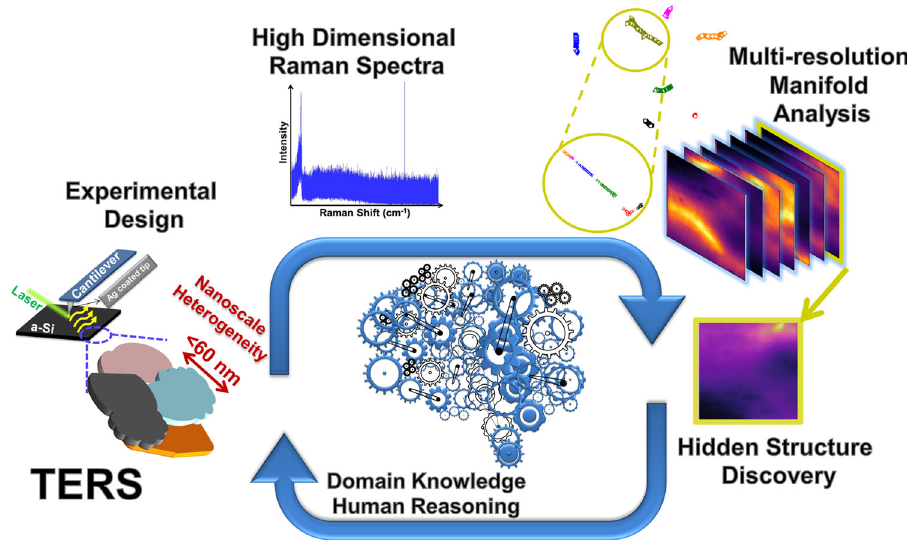
Fig. 1 The integrated work fl ow comprising hyperspectral TERS imaging and the multi-resolution manifold learning (MML) algorithm. The low dimensional physical parameters characterizing material structures such as local defects and atomic vibrations are translated into the high dimensional Raman spectra via hyperspectral tip-enhanced Raman spectroscopy (TERS) imaging transfer functions. The intrinsic low dimensionality of the physics suggests the structure of TERS measurements on the sample as a whole can be projected to a low dimensional latent manifold space via the multiresolution manifold learning (MML). Exploration data analysis such as clustering can be ef fi ciently conducted on the low-dimensional manifold space to reveal salient features for evaluating material structure heterogeneity by human reasoning and updating domain knowledge in a